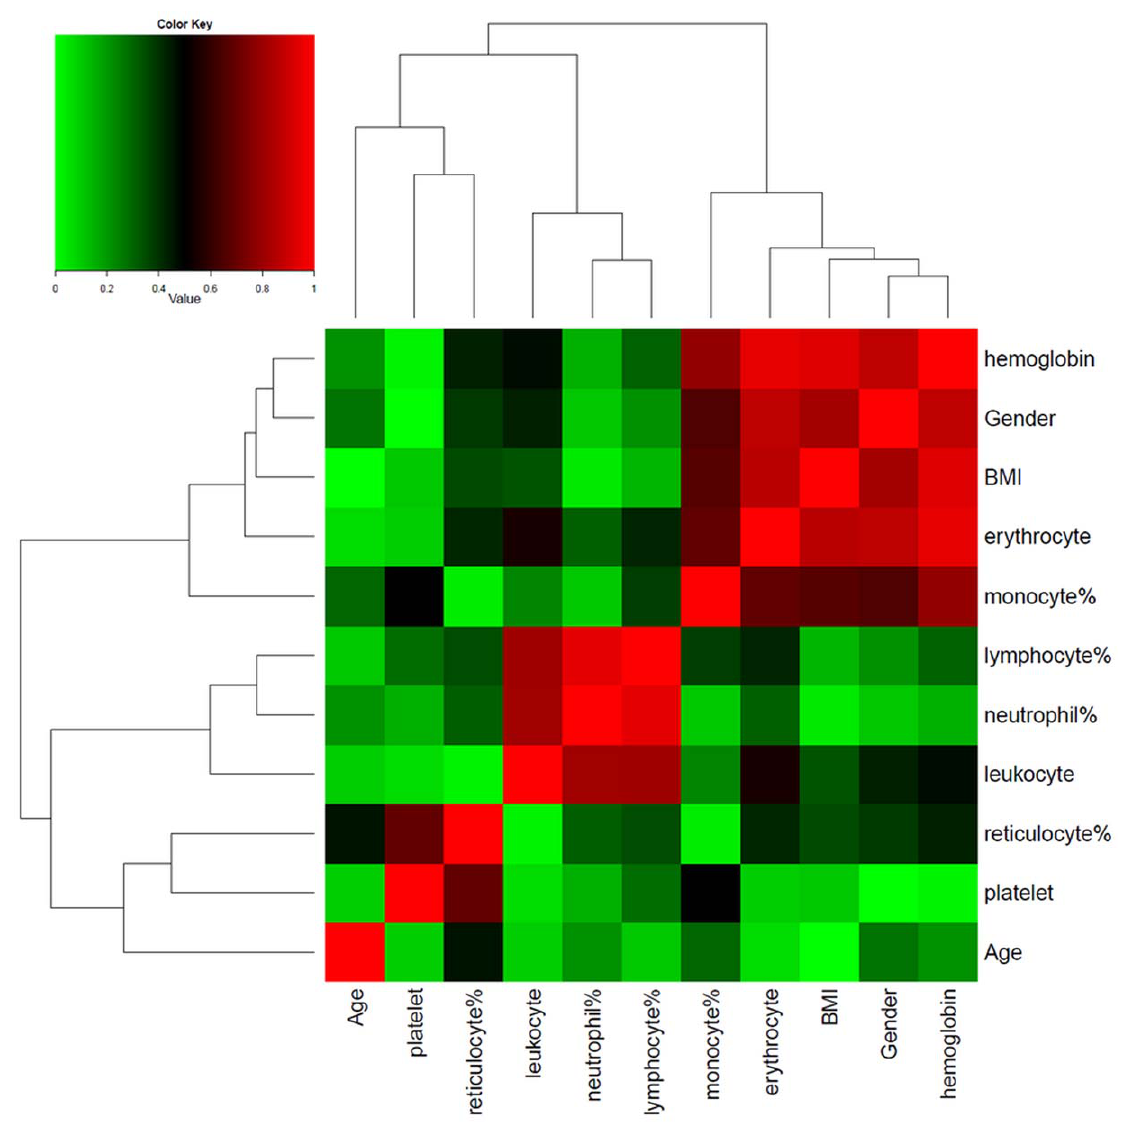
Figure 1. The study design for evaluating the impact of RNA quality on the blood gene expression profiles. From each healthy volunteer, 2.5 ml of peripheral blood was collected using a PAXgene TM Blood RNA tube. The extracted total RNA from each individual was aliquoted into three tubes. The 1 st tube was kept intact, while the 2 nd and 3 rd tubes were heated at 70 u C for 10 and 20 minutes, respectively. According to the RNAs processing, microarray experiments were then performed in the sequential series: Series_1, Series_2 and Series_3. The RIN value was measured and used as the technical variable for evaluating the impact of RNA quality on the blood gene expression profiles.